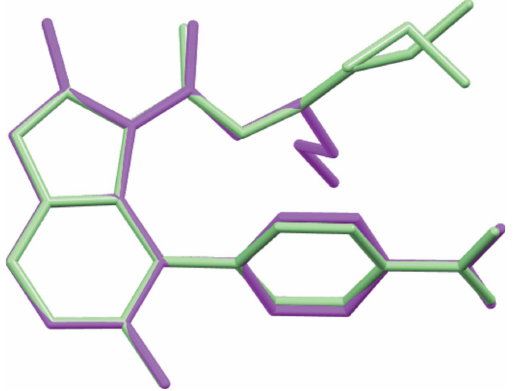
Figure 4 Superimposition of BF1 (light green) with BF2 (magenta) molecules showing the different orientation of the ester groups. H atoms are not included for clarity. The two positions of the disordered butyl group are shown for BF1.